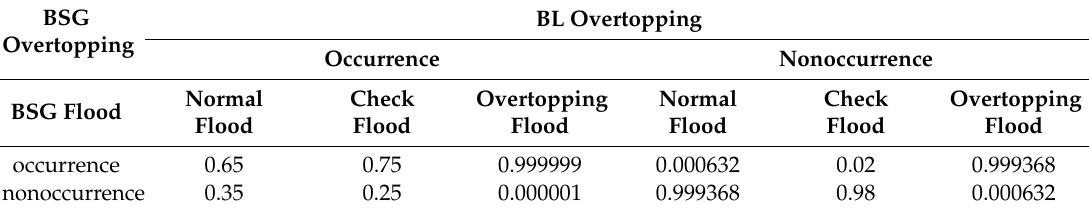
Table 4. The control probability table of Busigou (BSG) Overtopping.